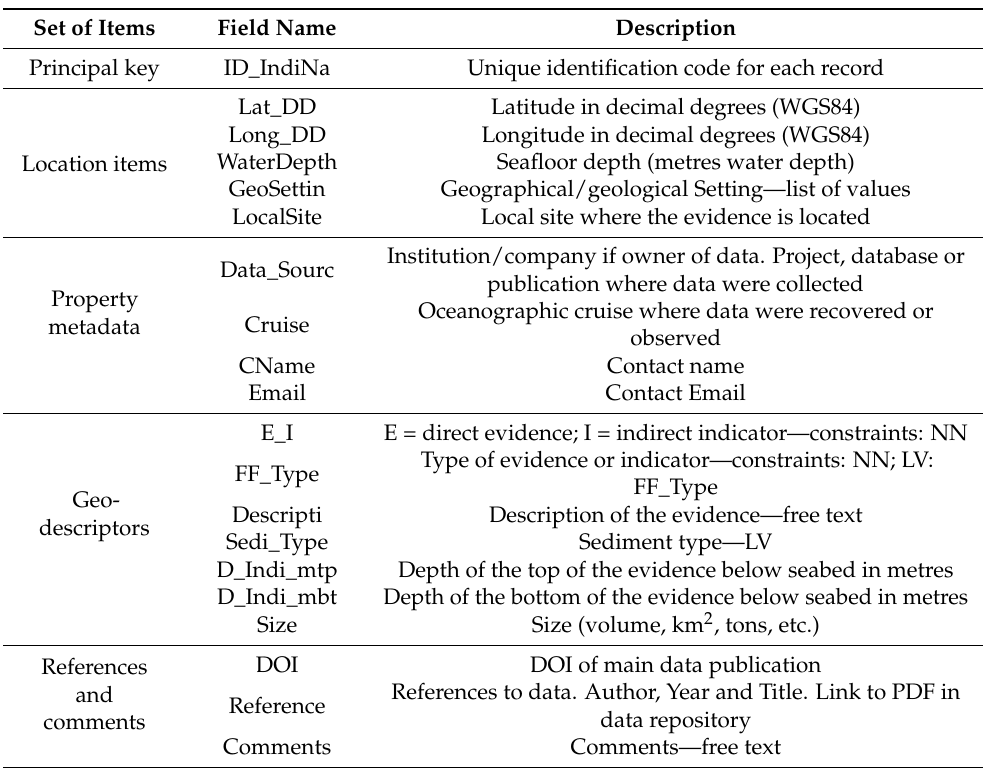
Table 1. Description of the attributes (items) of the GARAH ydrates GIS database. NN, not null; LV, list of